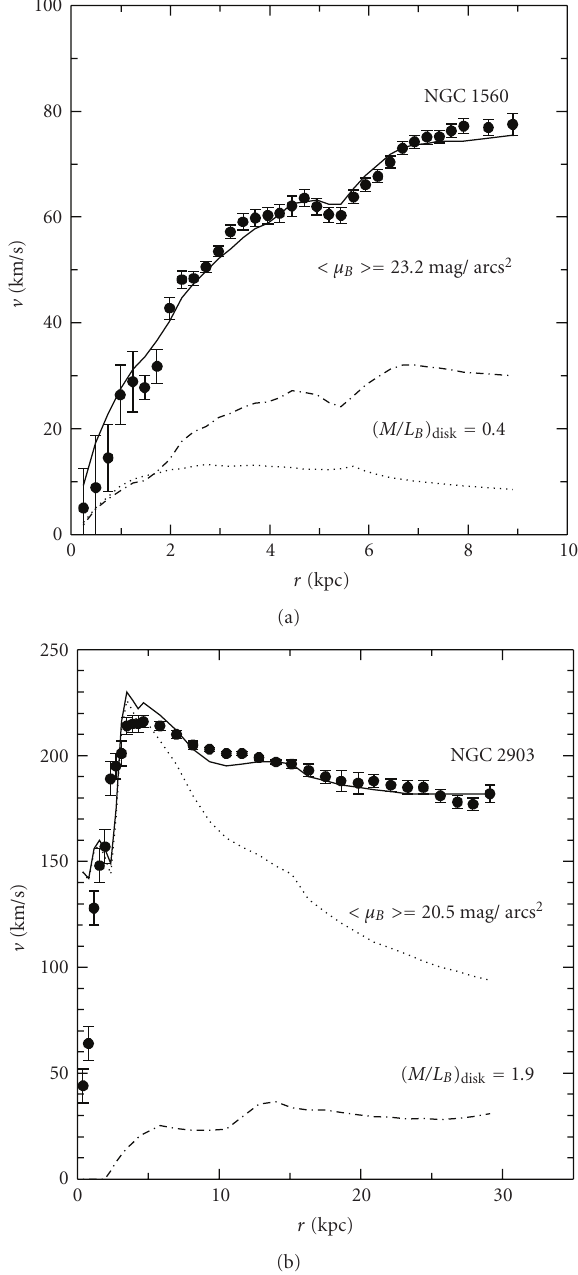
Figure 3: The points show the observed 21cm line rotation curves of a low surface brightness galaxy, NGC 1560 [9] and a high surface brightness galaxy, NGC 2903 [10]. The dotted and dashed lines are the Newtonian rotation curves of the visible and gaseous components of the disk and the solid line is the MOND rotation curve with a o = 1 . 2 × 10 − 8 cm/s 2 —the value derived from the rotation curves of 10 nearby galaxies [12]. Here the only free parameter is the mass-to-light ratio of the visible